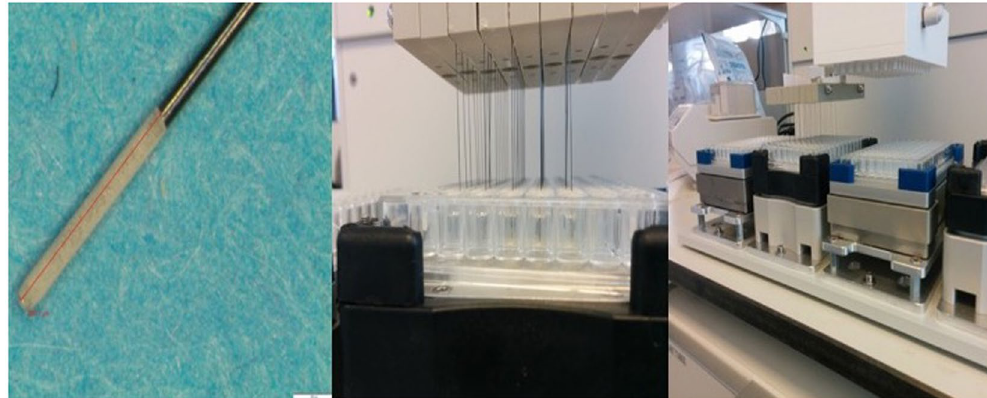
Figure 2. HLB coated nitinol fibers and automation of the fiber SPME for high throughput in vitro studies. Left figure illustrates an ultra-thin coated SPME fiber, middle figure shows a typical assembly of SPME fibers for high throughput extraction from biological sample, and right figure demonstrates automation of entire sample preparation protocol for in vitro non-depletive